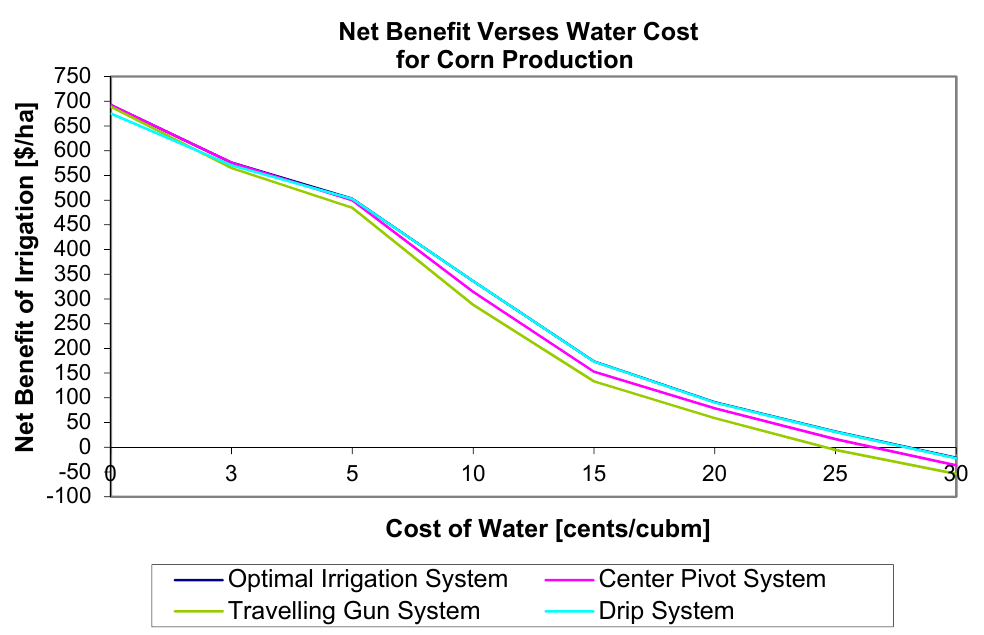
Figure 2. Irrigation system comparison of net benefit versus water cost associated with corn production.